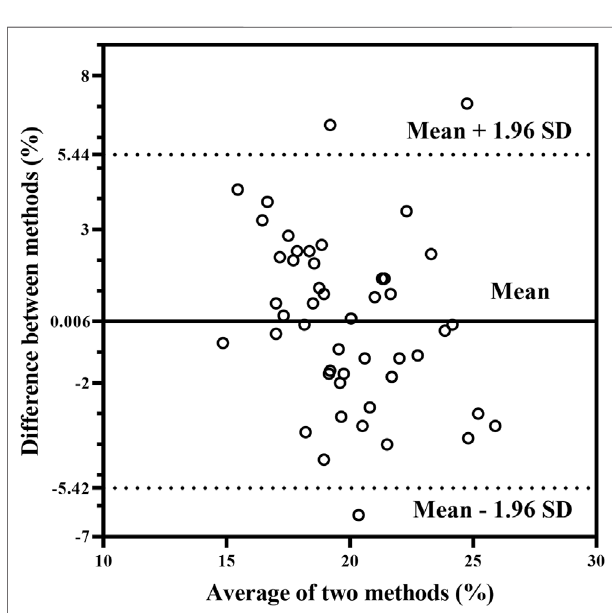
FIGURE 2 | Bland and Altman plots between TL HRV and RPE.